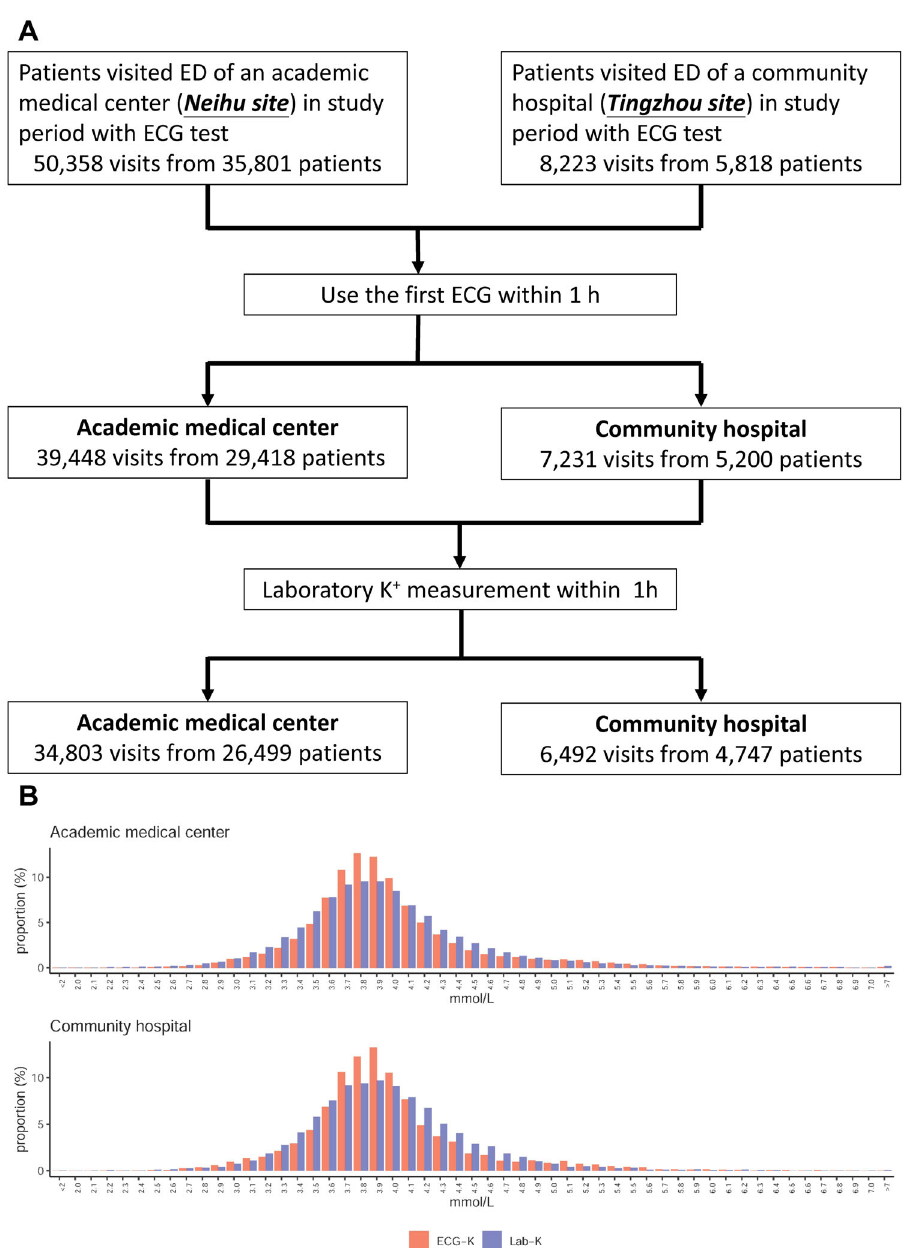
Fig. 1 Study cohorts ’ summary. A Dataset generation based on emergency department visits to an academic medical center and a community hospital; ( B ) The distributions of ECG-K + and Lab-K + at the academic medical center and community